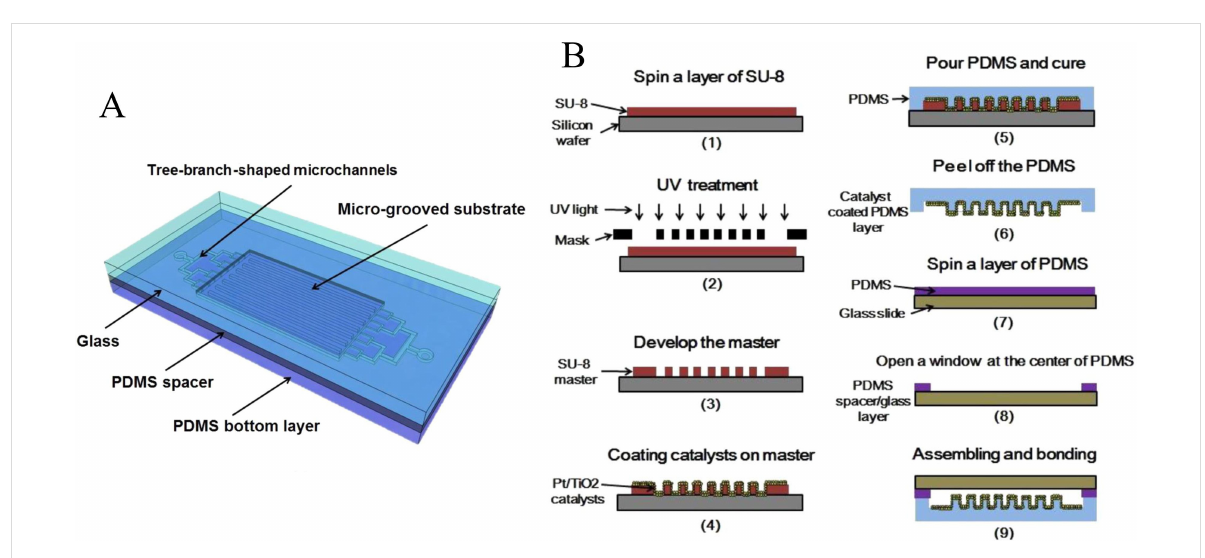
Figure 5: (A) Schematic of the high-surface-area optofluidic microreactor with micro-grooved structure. (B) Fabrication procedure of the optofluidic microreactor with the catalysts on the PDMS substrate. Adapted from [36], copyright 2015 Elsevier Ltd.